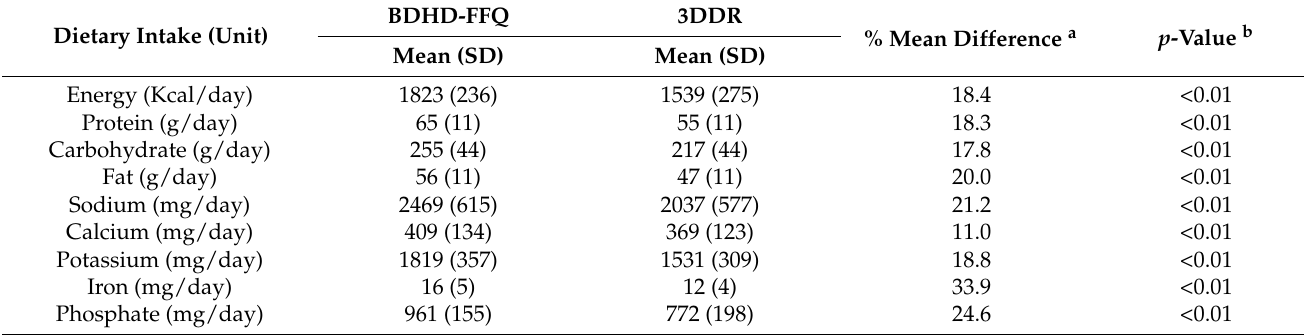
The weighted kappa coefficient showing highest for energy (0.43, 95% CI: 0.30–0.55), and the lowest for iron (0.12, 95% CI: 0.02–0.27) (see Table 6). A result between 0 and 1 for the weighted kappa coefficient is commonly expected agreement (excluding chance) at the individual level. Negative numbers imply an agreement “worse” than can be pre- dicted by chance alone, whereas values of zero or near to zero indicate “no more than Table 6. Agreement of cross-quartile classification and weighted Kappa between BDHD-FFQ and 3DDR.